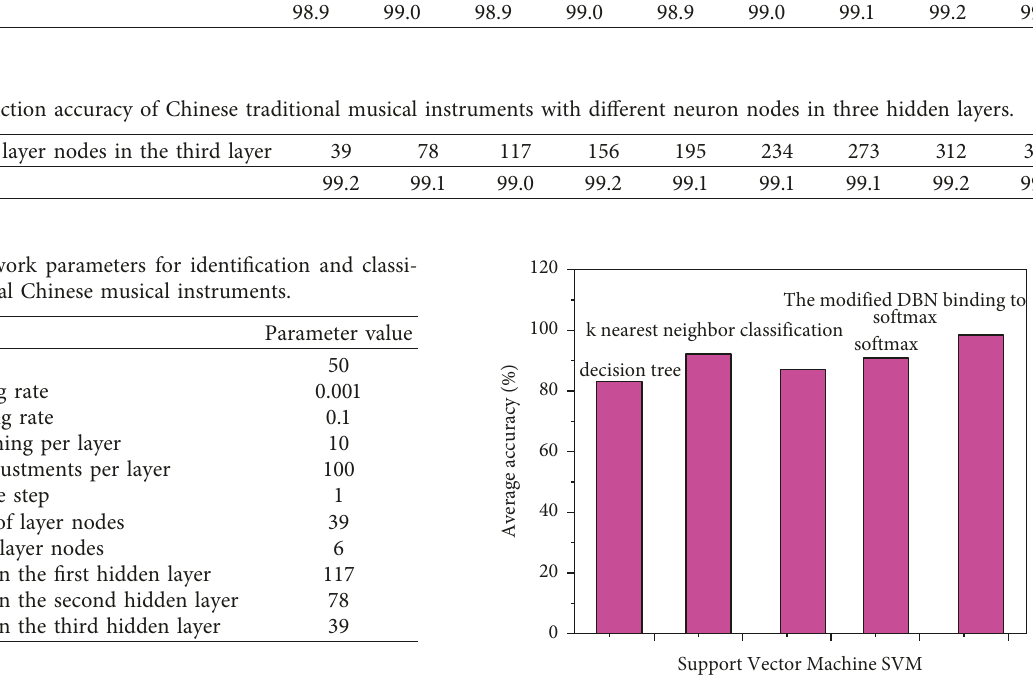
Figure 7: Average accuracy of the deep confidence network model in the classification of Chinese traditional musical